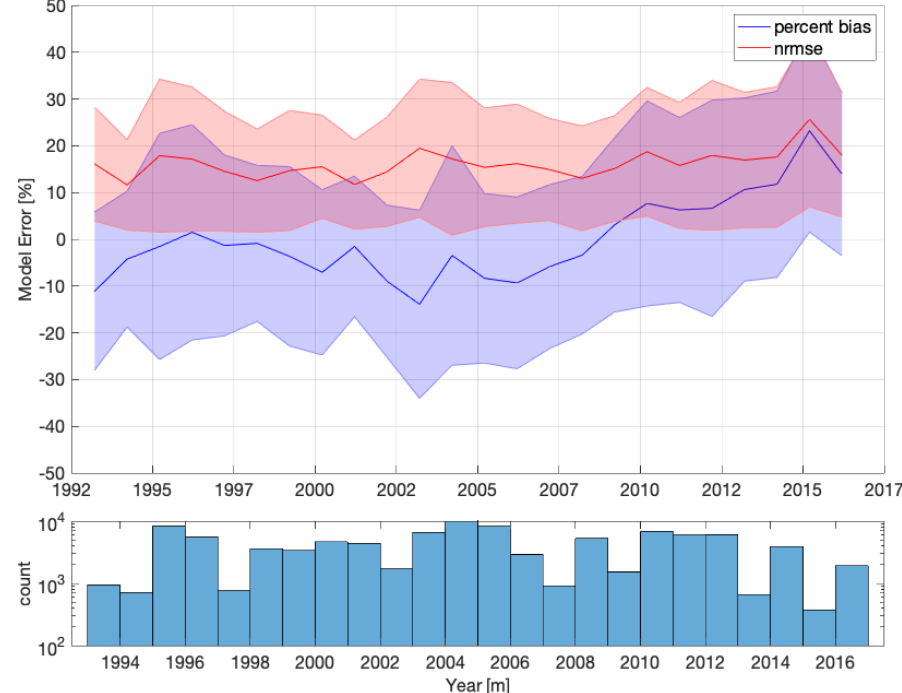
Figure 7. As in Figure 6 over time indicated in years with 1 year